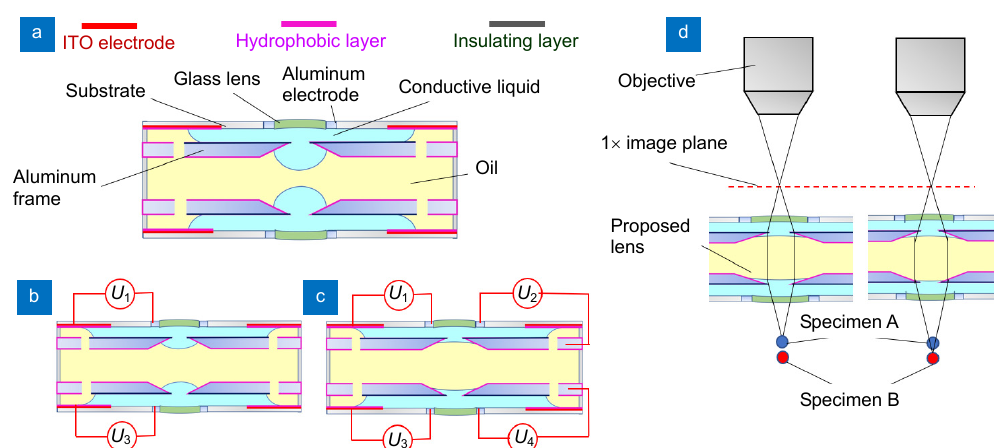
Fig. 1 | Schematic cross-sectional structure and operating mechanism of the movable electrowetting optofluidic lens . ( a ) Cell structure. The curvature of the silicone oil (yellow)-conductive liquid (blue) interface in the central aperture is regulated by the external voltages. ( b ) Moving actuation. When the external voltages U 1 and U 3 are applied, the L-L interface moves downwards. ( c ) Deforming actuation. When external volt- age U 2 and U 4 are applied, the L-L interface deforms. ( d ) Working principle of axial